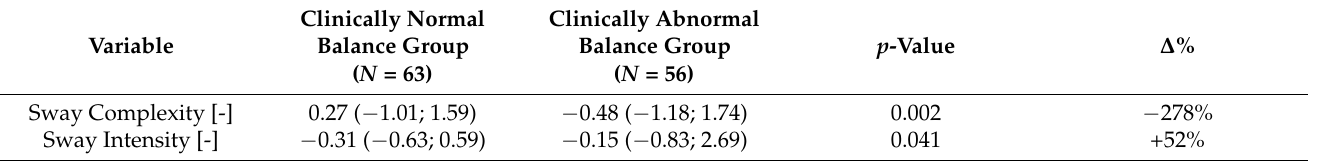
Table 5. ImRomberg components scores for participants with and without clinically normal balance.